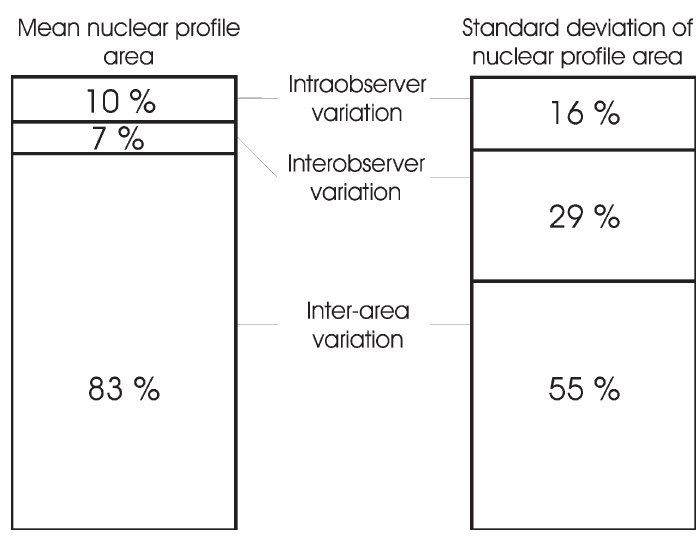
Fig. 5. The relations of the different sources of variation in the morphometric measuring method for mean nuclear profile area and for SD of nuclear profile area. The variation associated with the selected measurement areas and microscope fields is responsible for the largest fraction of the total variation. This reflects the biological variation within single